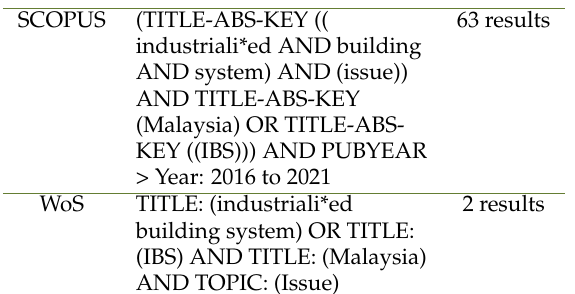
Table 1. Search strings from Scopus and WoS SCOPUS 63 results